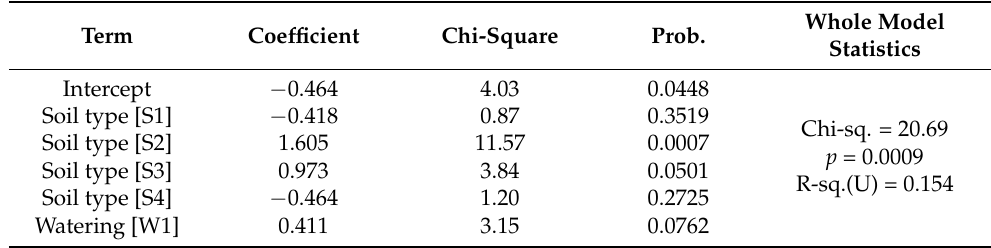
Table 2. Effect term coefficients and goodness-of-fit statistics associated with the model estimating the log odds of seed germination (Yes/No) by level of watering and soil type. Term